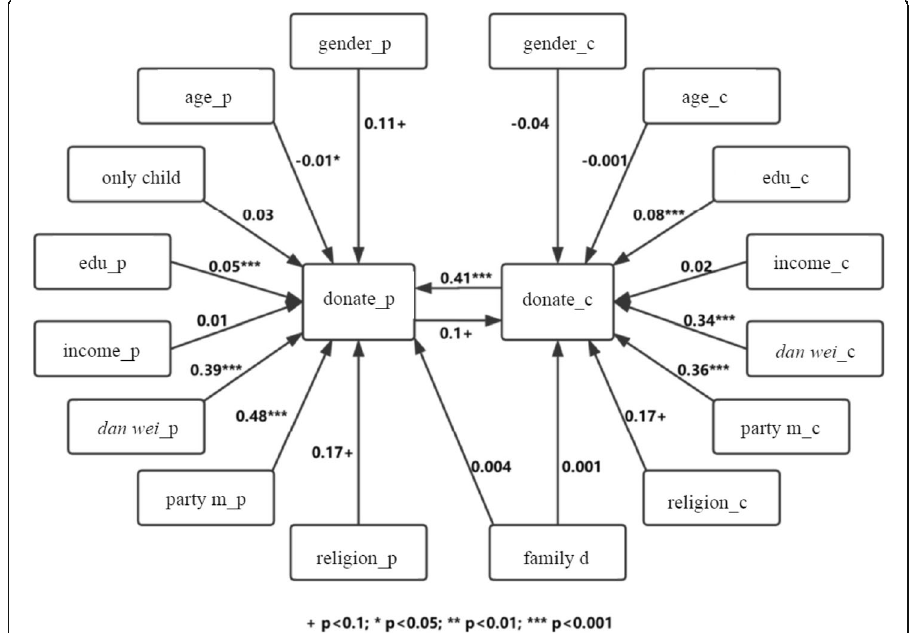
Fig. 3 Mutual influence of donation between parents and adult children ( N = 6120). Note: “ _p ” represents parentage, “ _c ” represents children, “ family d ” denotes donation in the name of the family, “ edu ” denotes education, and “ party m ” denotes party membership